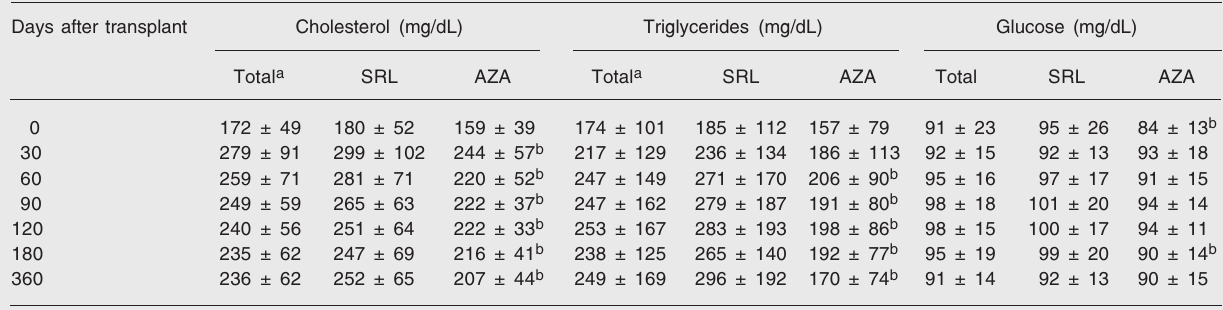
Table 3. Cholesterol, triglyceride and glucose concentrations during the first year of transplant in patients receiving sirolimus or azathioprine in combination with cyclosporine and prednisone. Days after transplant Cholesterol (mg/dL) Triglycerides (mg/dL)